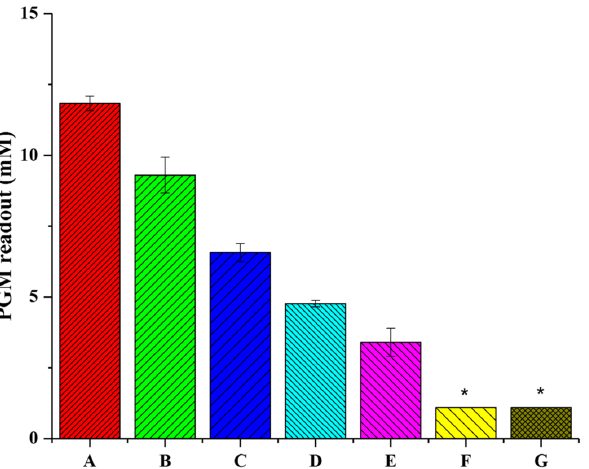
Figure 2. The PGM readout of seven solutions. ( A ) Ascorbic acid solution + glucose solution (molar ratio: 1:1); ( B ) Ascorbic acid solution; ( C ) α-Glucosidase + AA-2G solution; ( D ) α-Glucosidase + AA- 2G + acarbose solution; ( E ) Glucose solution; ( F ) AA-2G solution; ( G ) α-Glucosidase + acarbose